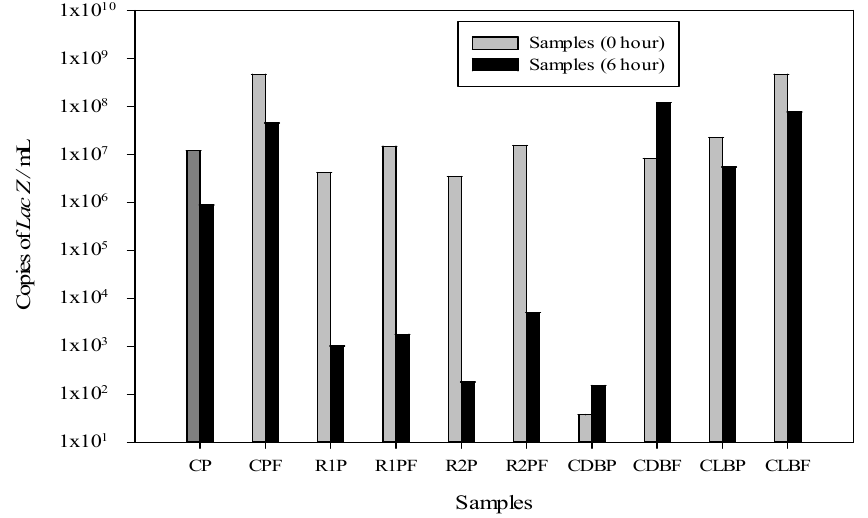
Figure 3. Inhibitory effect of f- cork on E. coli using PMA staining. Gene copy numbers of LacZ gene/μL present in the biolfiltration system at 0 and 6 h. Biofilter control without f- cork with PMA (CP), Biofilter control without f- cork and without PMA (CPF), Replicate of biofilter with f -cork and PMA (R1P), Replicate of biofilter with f -cork and without PMA (R1PF), Control of dead bacteria with PMA (CDBP), Control of dead bacteria without PMA (CDBF), Control of live bacteria with PMA (CLBP) and Control of live bacteria without PMA (CLBF).